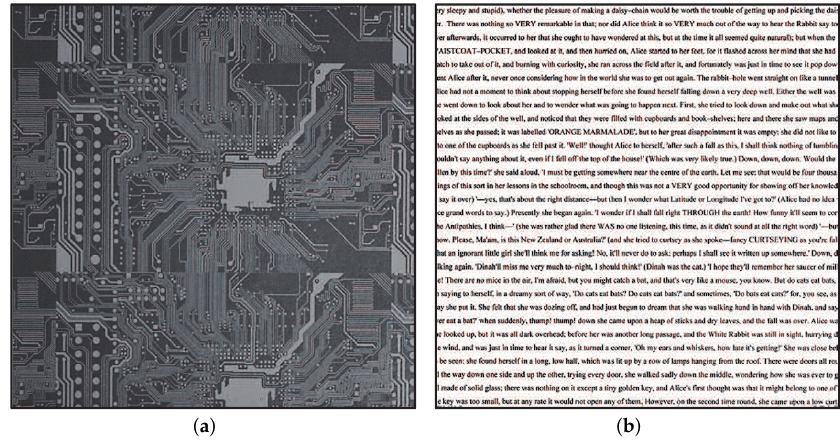
Figure 20. Electronic board pattern and book page pattern to be observed: ( a ) electronic board pattern; ( b ) book page